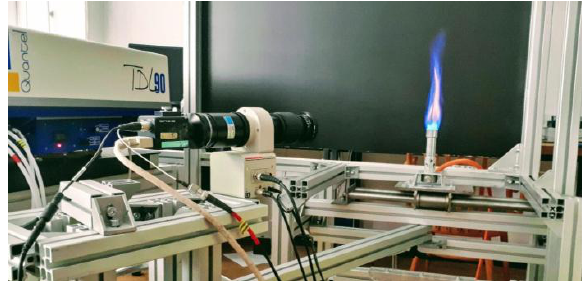
Fig. 1. Experiment arrangement .